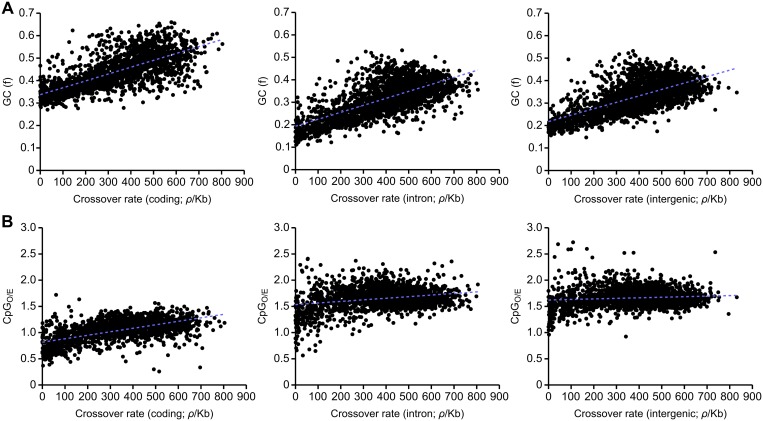
Correlations between recombination rate and GC and CpG content divided according to functional categories.(A) Correlations between recombination rate and GC content in coding (left panel; R2 = 0.506, p<10-5), intronic regions (centre panel; R2 = 0.463, p<10-5) and intergenic regions (right panel; R2 = 0.446, p<10-5). (B) Correlations between recombination rate and CpGO/E in coding (left panel; R2 = 0.369, p<10-5), intronic regions (centre panel; R2 = 0.066, p<10-5) and intergenic regions (right panel; R2 = 0.011, p = 0.00037). 100 kb genomic windows are used in each comparison.